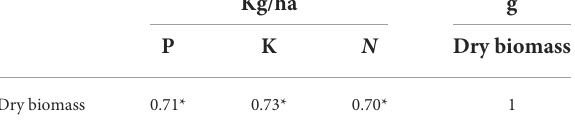
TABLE 5 Pearson’s correlation test on plant nutrient uptake (N, P, K) with dry biomass on a soybean cropping system.